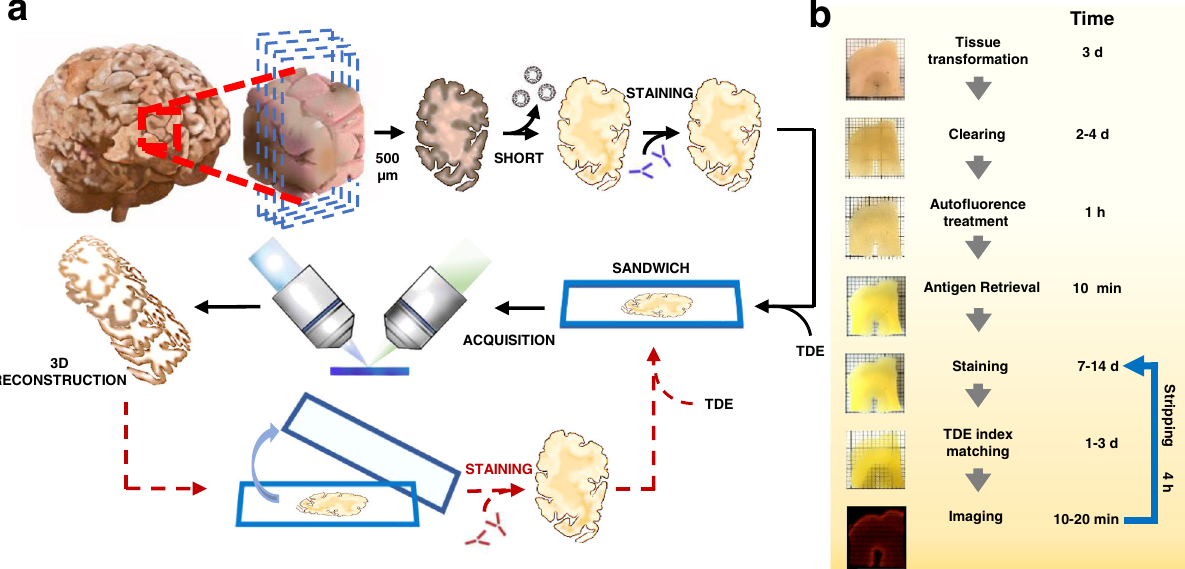
Fig. 2 Outline and timing of SHORT. a The entire SHORT protocol, from the whole human brain sample to imaging, requires three weeks. This consists mainly of incubation time, re fl ected in the ‘ Time ’ column for each step ( b ). During days 1-3, SHORT processing slices were performed. On days 4-8, the removal of the lipid takes place. On day 9, peroxide oxygen treatment (1 h) and AR (10 min) were performed. On days 9 – 15, the primary antibodies were incubated. The secondary antibody incubation was performed during days 15-19. Finally, the samples were acquired using LSFM and, then, reconstructed using Zstitcher. Additionally, the processed samples can undergo multiround staining for proteome